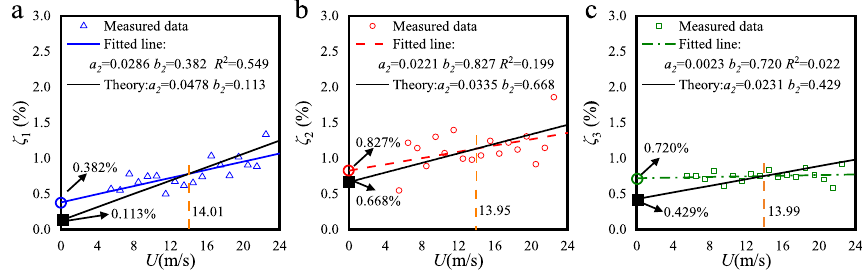
Fig. 16 Relationship between measured modal damping ratios and wind velocity in the first three vertical bendings of PSRB using SSI-COV: a First-order; b Second-order; c